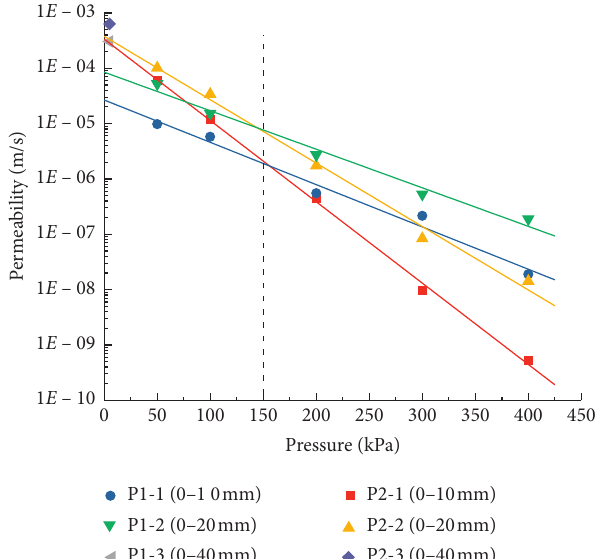
Figure 5: Relationship between the permeability and the pressure of samples with different particle sizes.